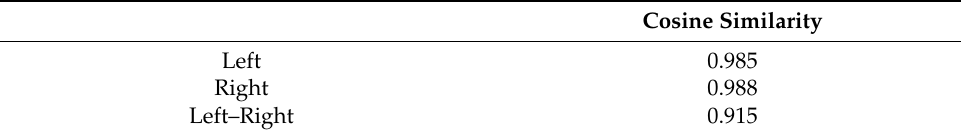
Table 1. Cosine similarity within one ear data and between two